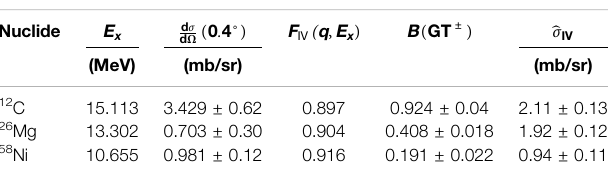
TABLE 1 | Data used for obtaining IV UCSs.